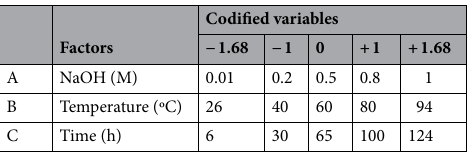
Table 4. Variables and levels used in the central composite optimization